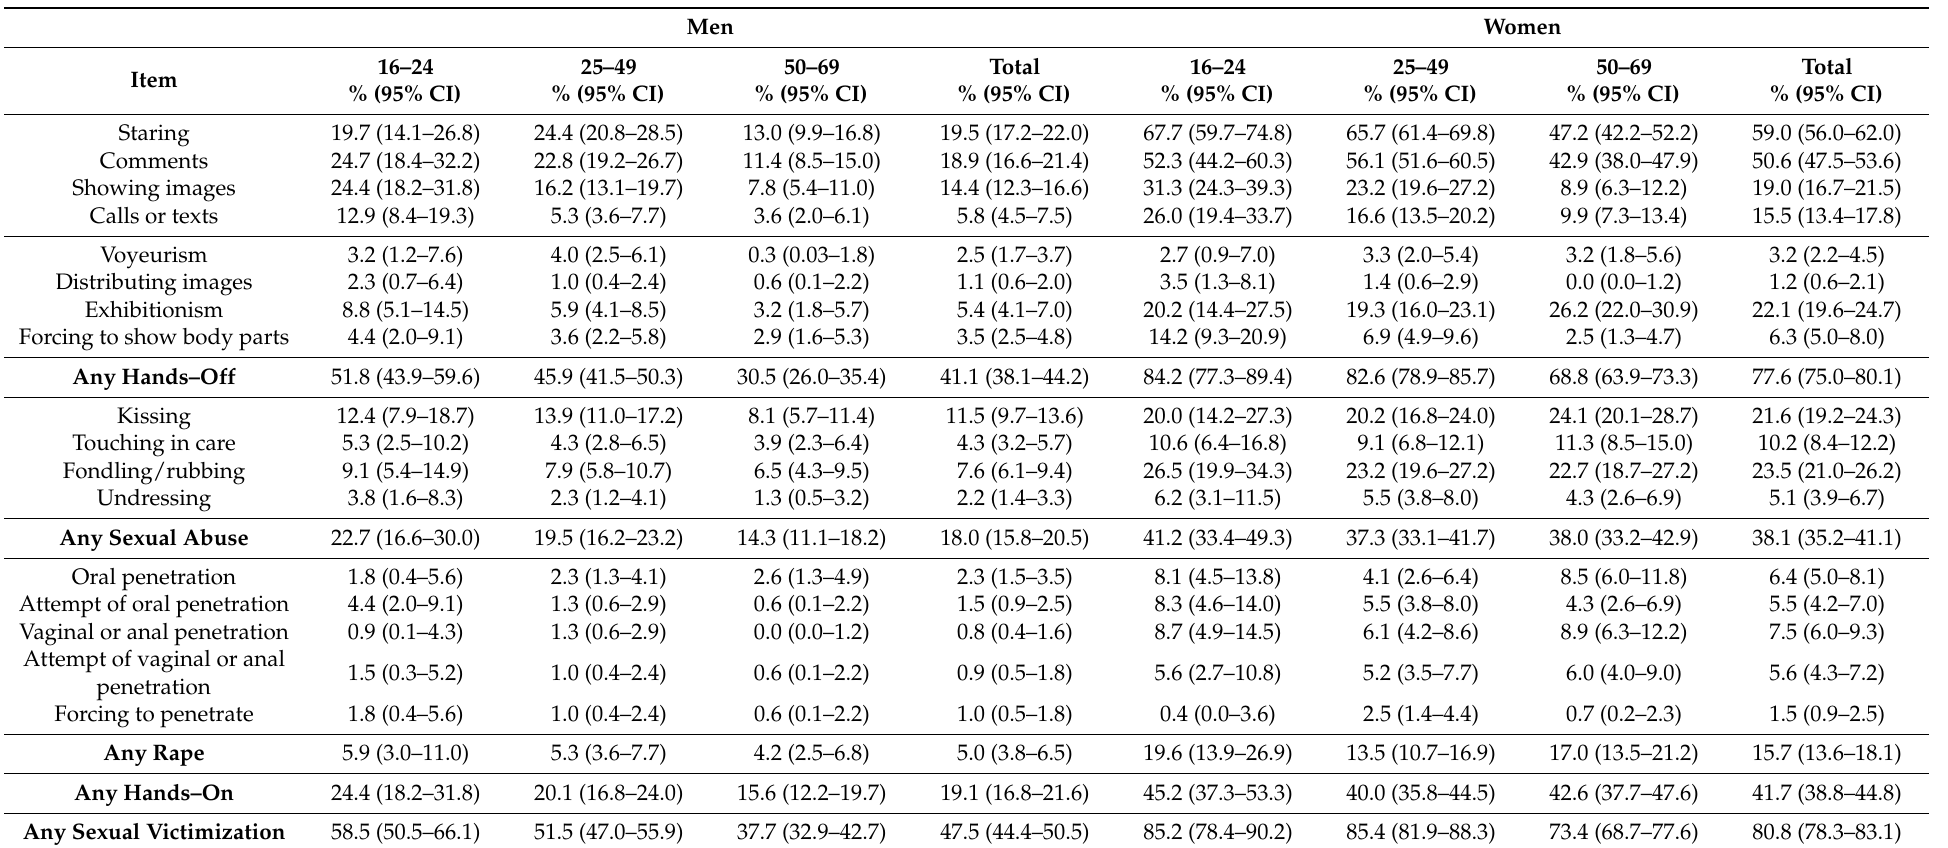
Table 3. Detailed and grouped weighted lifetime prevalence estimates sexual victimization, by sex and